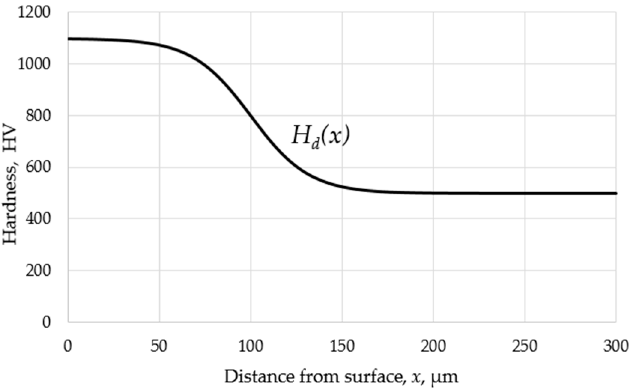
Figure 4. The sigmoid function representing the H d ( x ) in-depth hardness distribution.